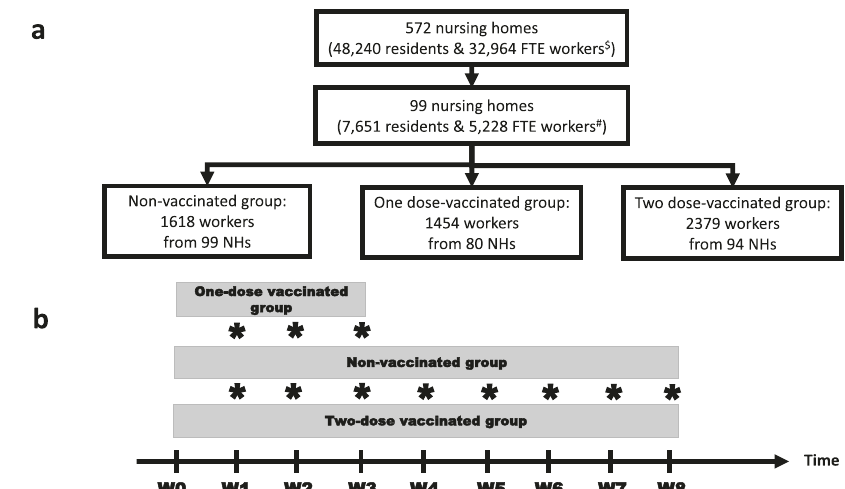
Fig. 1 Experimental fi eld design of the cohort study. a Study participants enroled. b Duration of the observation. $ The number of nursing homes (NHs), residents and workers were estimated in a previous study 21 . # FTE, full-time equivalent. In the 99 studied NHs, the number of residents was estimated at 7.651 individuals. Based on a ratio of 20.5 equivalent full-time workers for 30 residents 16 , the estimated study population of NH workers was around 5228 adults. During the study, the maximum number of participating NH workers (i.e., physical persons; not all are employed full time) exceeded slightly the estimated FTE number by 4.38% (5457 versus 5228). *, points of comparison between each vaccinated group and the non-vaccinated